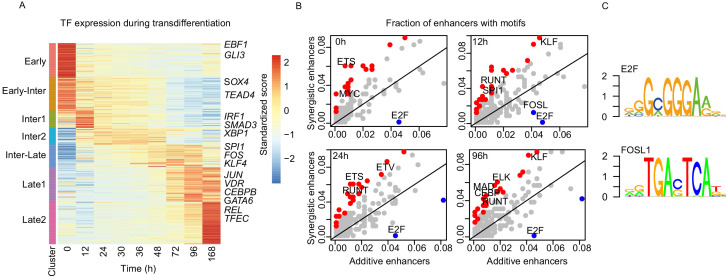
Specific sets of TFs are enriched on synergistic enhancers.(A) Heatmap of differentially expressed TFs from RNA-seq (| log2(FC) |>1, FDR < 0.05) for seven clusters obtained with k-mean clustering (Figure 1C). (B) Bound TF motif occurrences were calculated from TF footprinting with ATAC-seq at each indicated time point. Each dot represents a fraction of synergistic enhancers with a TF motif to a fraction of additive enhancers with a TF motif. TF motifs that are bound significantly more within the synergistic or additive enhancers are indicated in red or blue, respectively (Fisher’s exact test p-value < 0.05). (C) Motifs of TFs enriched in additive enhancers upregulating genes at 96 hr from TF footprinting analysis (Materials and methods).